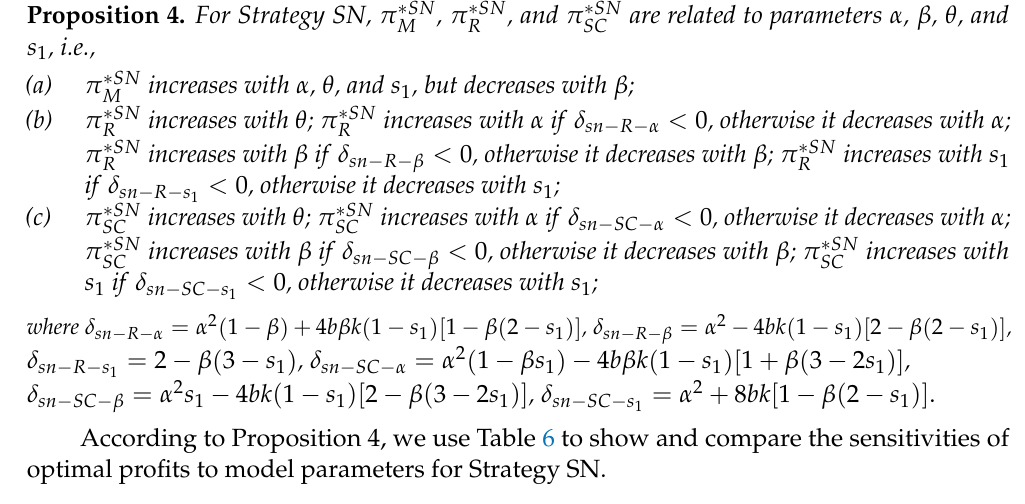
Table 6. The sensitivities of optimal profits to model parameters for Strategy SN. α β θ s 1 ↑ ↓ ↑ ↑ π ∗ SN M ↓↑ ↓↑ ↑ ↓↑ π ∗ SN R ↓↑ ↓↑ ↑ π ∗ SN SC